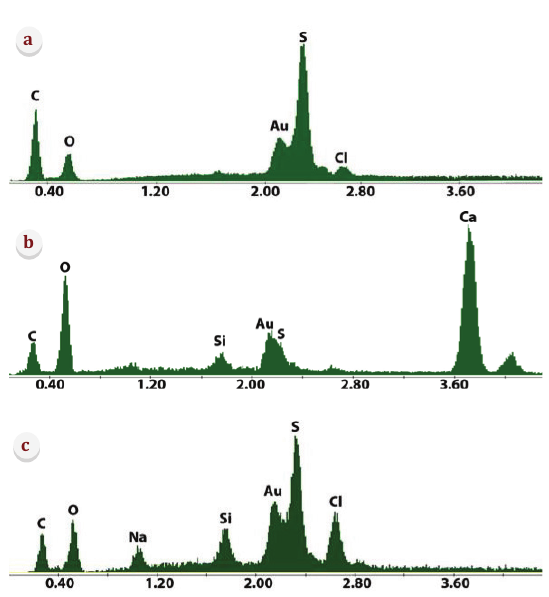
Fig. 8 – Energy Dispersive Analysis (EDS) of the clean (a), fouled (b) and washed (c) Fig. 8 Energy Dispersive Analysis (EDS) of the lean (a), fouled (b) and washed (c) membranes